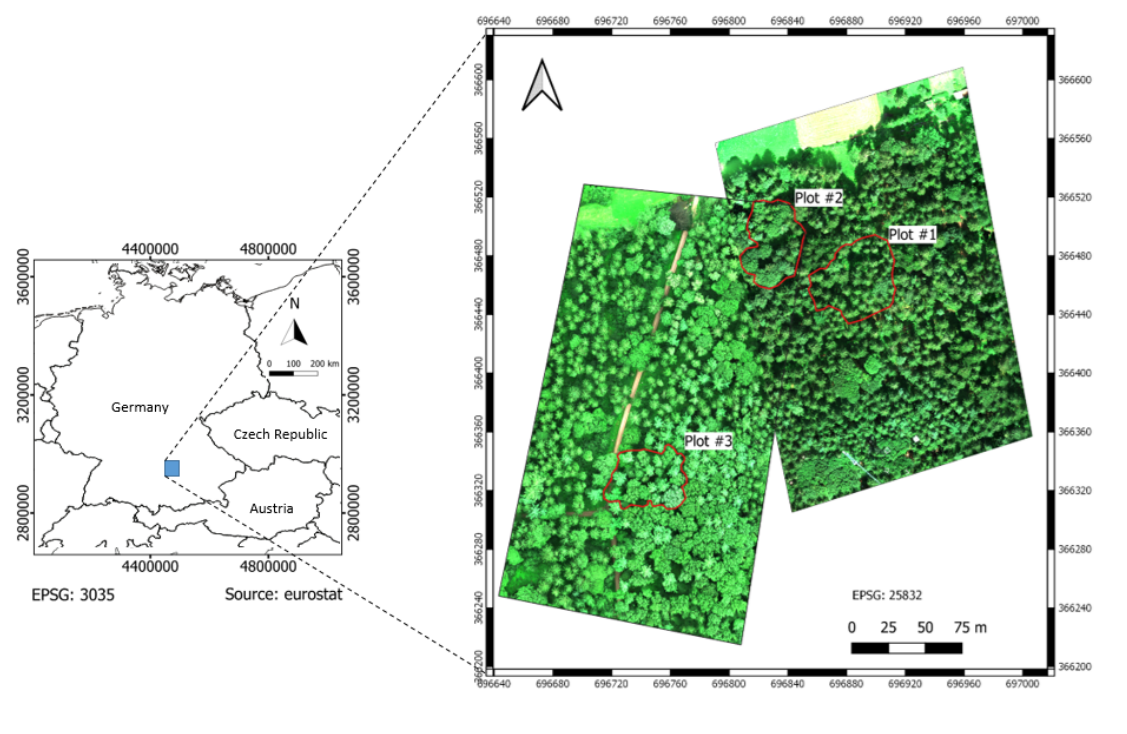
Figure 1. Research site KROOF as RGB TDOP showing three test plots #1, #2, and #3. The remaining area was used for training and validation.